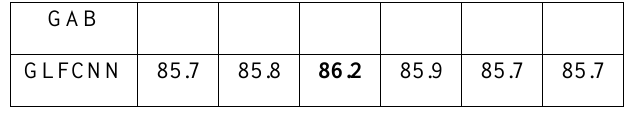
Table 2. The effect of different t values on F1 of GLFN-GAB and GLFCNN on the KBP37 dataset